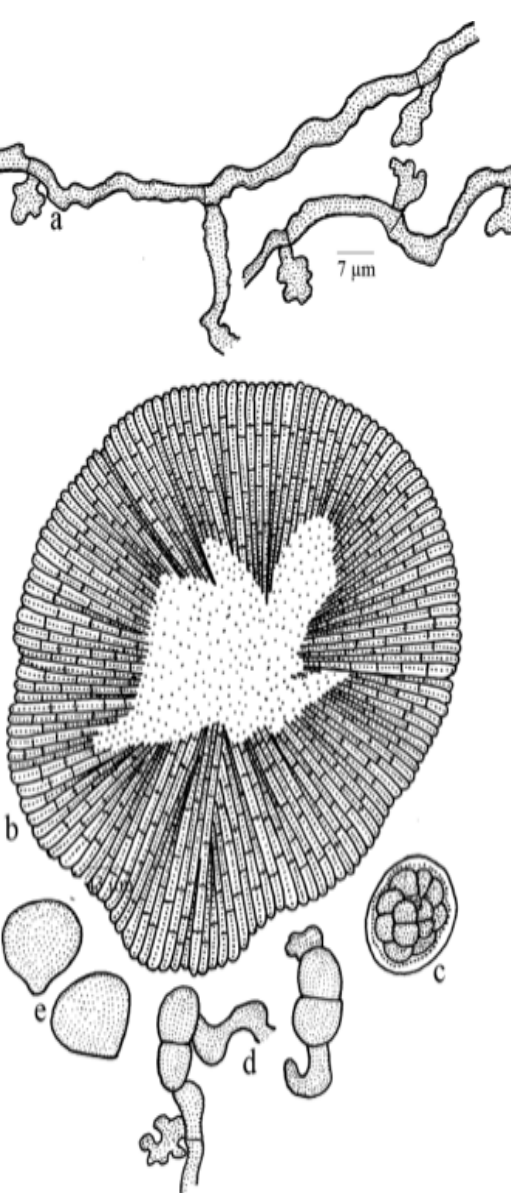
Figure-171. Asterina triumfetticola a -Appressorium, b. Thyriothecium, c. Ascus, d.